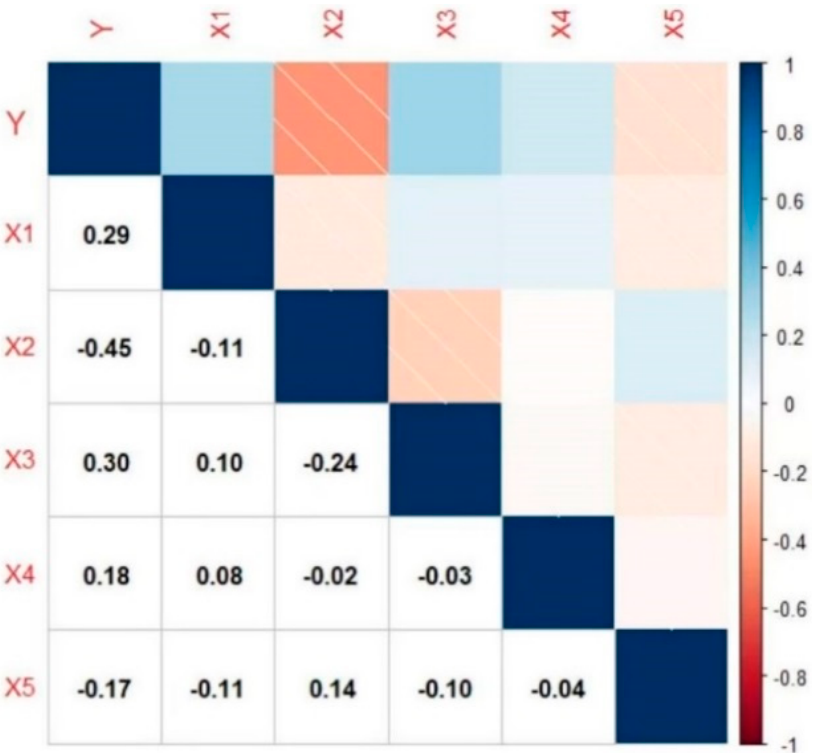
Figure 9. The relationships between forest damage severity (0 − 1) with elevation, slope, distance from typhoon track and precipitation (( a ): distance from typhoon track; ( b ): elevation; ( c ): slope; ( d ): precipitation).